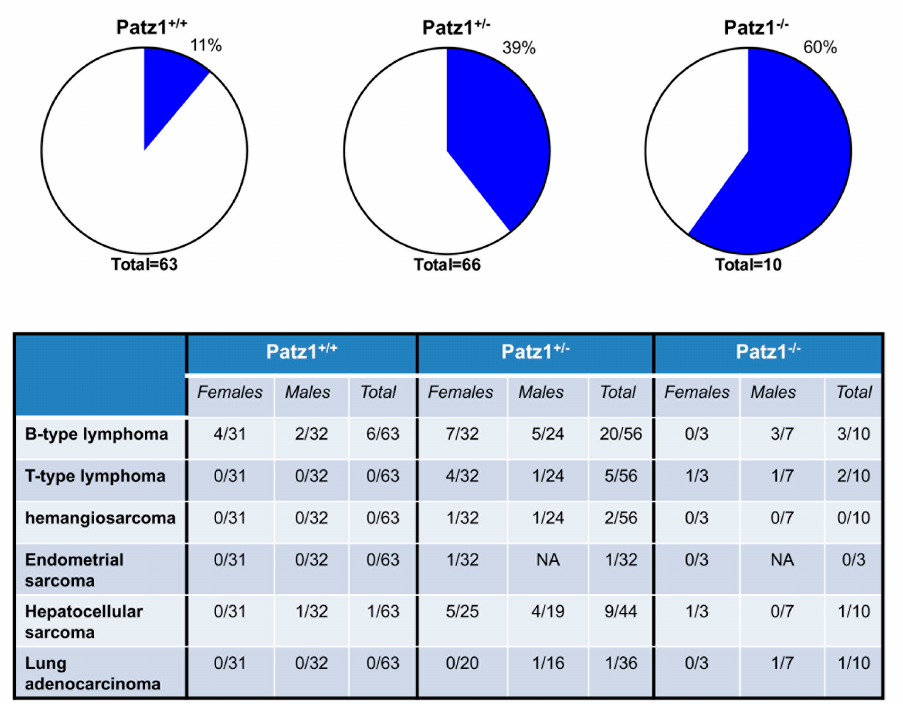
Figure 3. Malignant tumors in PATZ1 knockout mice. Percentage of mice showing malignant tumors are showed in pie charts on the top. The specific tumor phenotype, and relative number of mice showing it, is reported in the table. The mice analyzed were wild-type (Patz1 +/+ ) and carrying one (Patz1 +/ − ) or two (Patz1 − / − ) knockout allele. NA = not applicable.